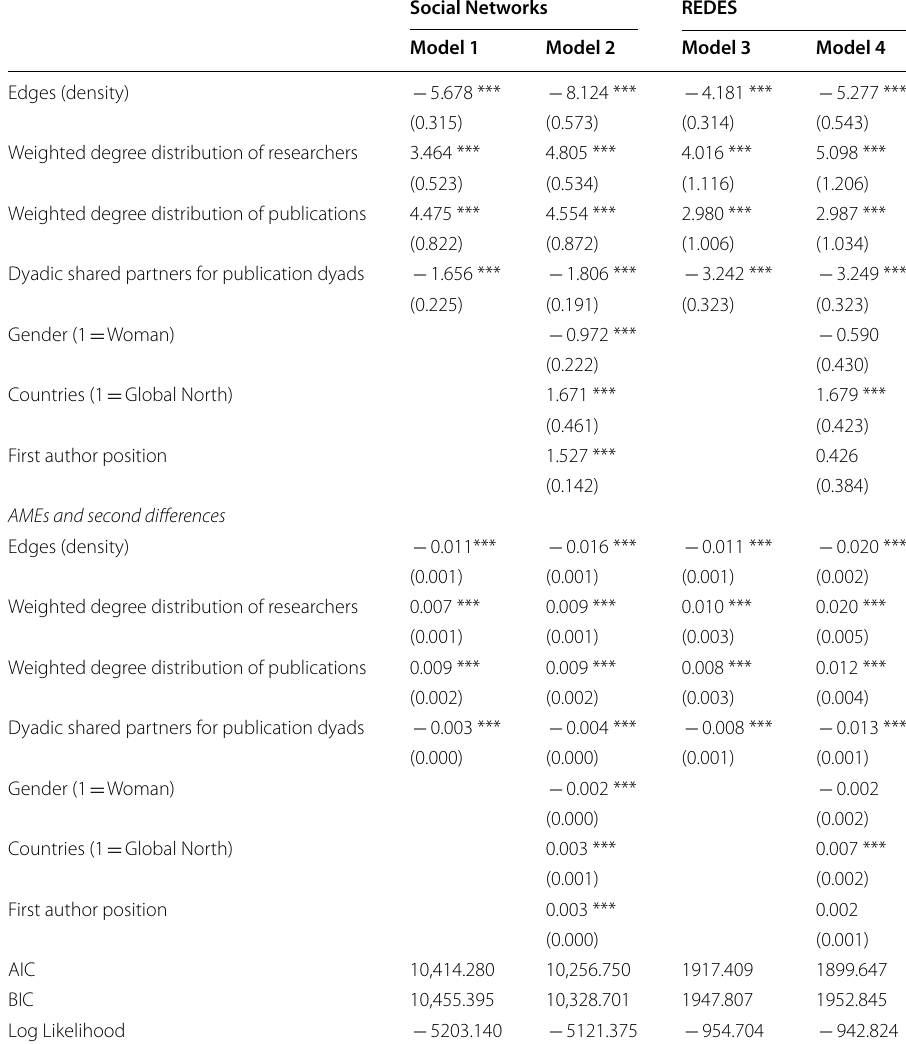
Table 2 Exponential random graph model for the social networks and REDES